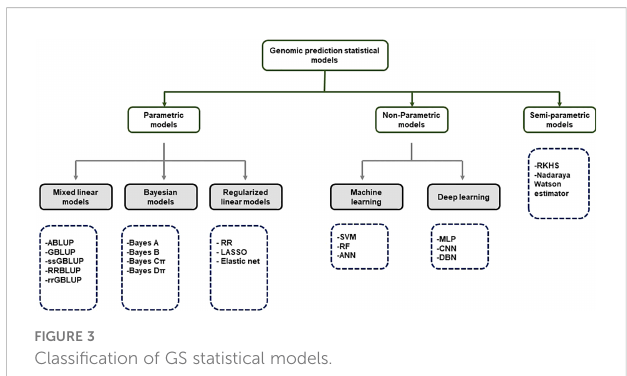
FIGURE 3 Classi fi cation of GS statistical